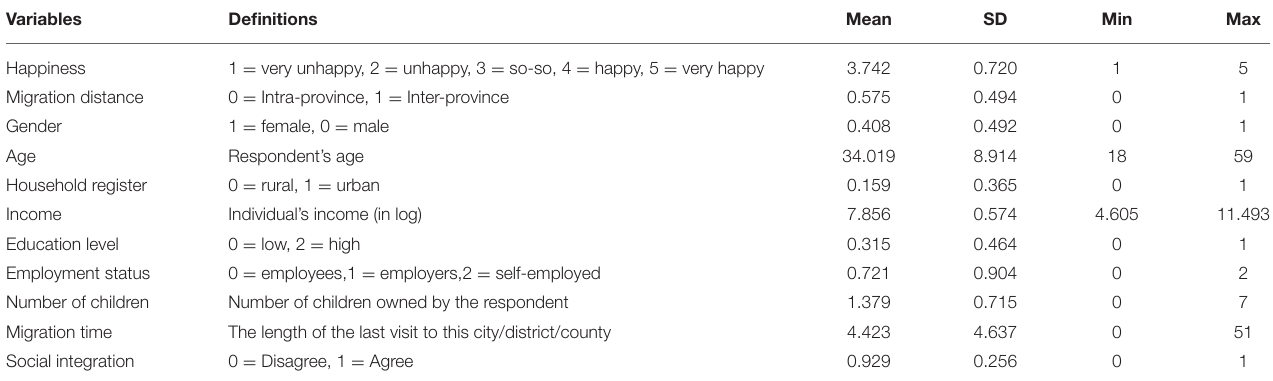
TABLE 1 | Descriptive statistics of the key